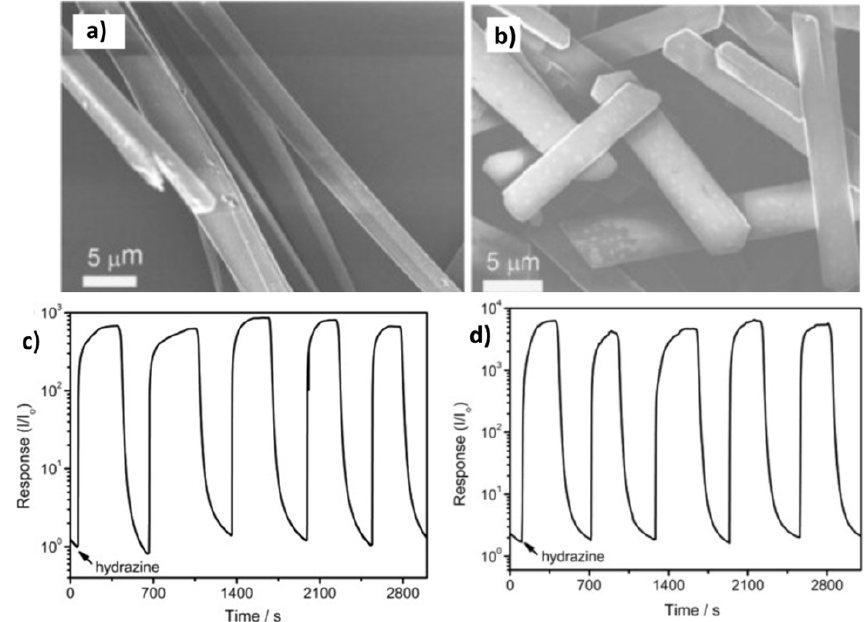
Figure 6. SEM images of ( a ) PDI-CNC 10 and ( b ) PDI-ClC 10 illustrating the similarity in a nanorod structure. Dynamic responses of ( c ) PDI-CNC 10 and ( d ) PDI-ClC 10 gas sensors towards 8 ppm of hydrazine vapor show the sensitivity increase of the latter based on the response value. Adapted with permission [34].